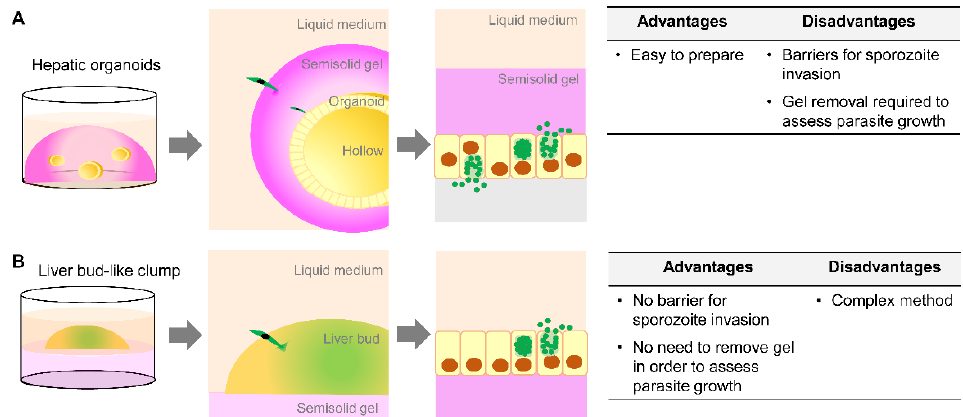
Figure 4. Proposed methods for the use of hepatic organoids or liver bud-like clumps. ( A ) Hepatic organoids (yellow-colored balls) are embedded in a semisolid gel (pink dome-shape) and covered with liquid medium (orange). Following sporozoite inoculation in liquid medium, sporozoites penetrate into the semisolid gel and reach the organoid. Subsequently, mature liver schizonts release erythrocyte-infectious merozoites in two ways: (1) floating in the hollow space (gray area) or trapping in the semisolid gel. ( B ) Liver bud-like cell clumps are directly exposed to liquid medium, allowing parasite invasion and the release of merozoite. The advantages and disadvantages of both of the proposed methods are